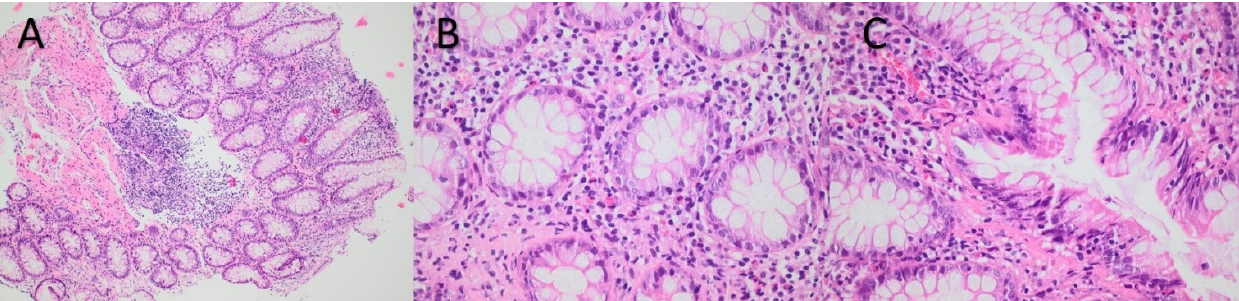
Figure 2. ( A ) Mucosa with normal architecture and mucin production showing moderate inflammatory infiltrate of the lamina propria. H-E stainx10. ( B ) Increased number of eosinophils in the lamina propria. H-E stainx40. ( C ) Extension of the eosinophils into the surface epithelium. H-E stainx40.